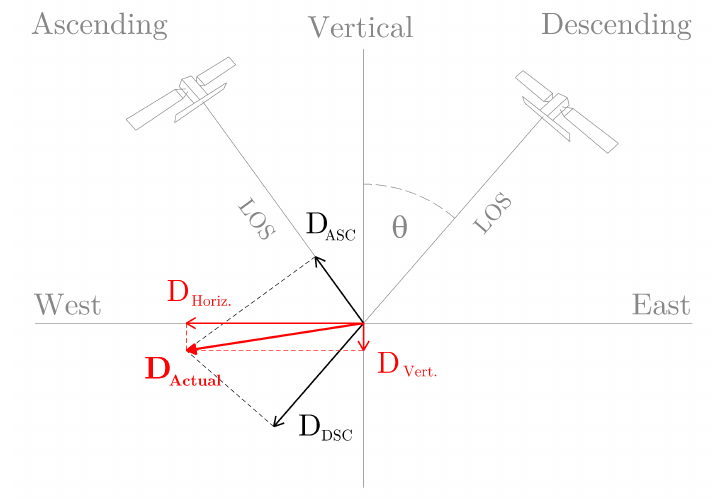
Figure 9. LOS velocities decomposition principle, specific case of Hradec landslide (Figure 8).